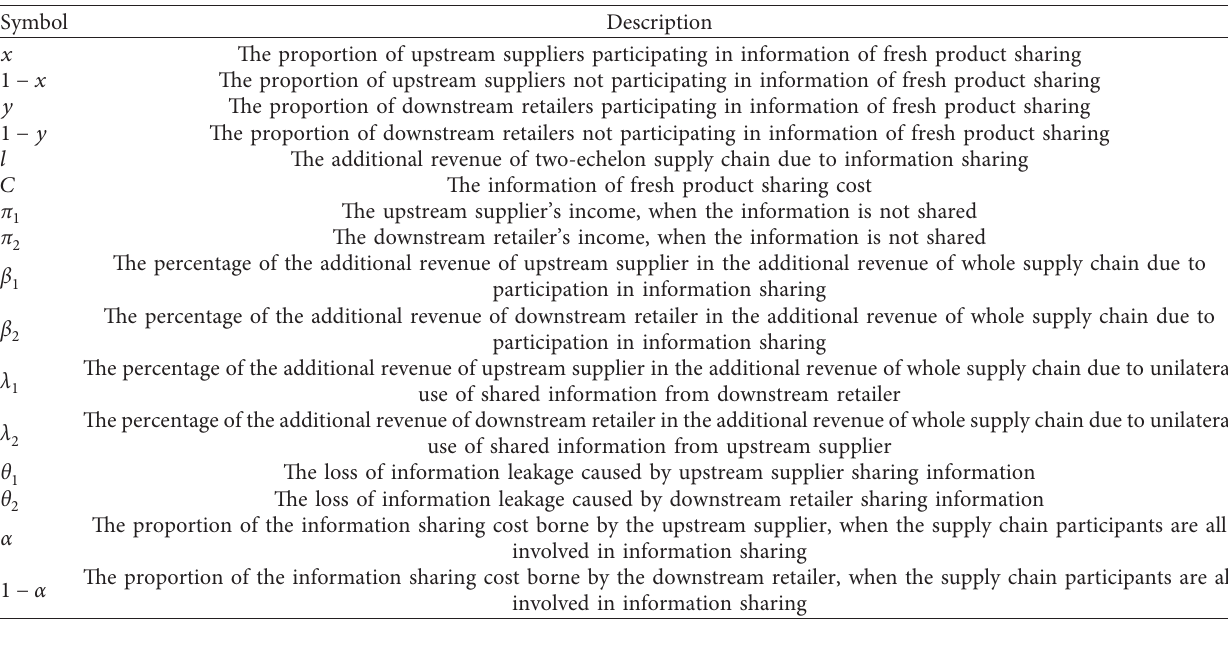
Table 1: List of notations.